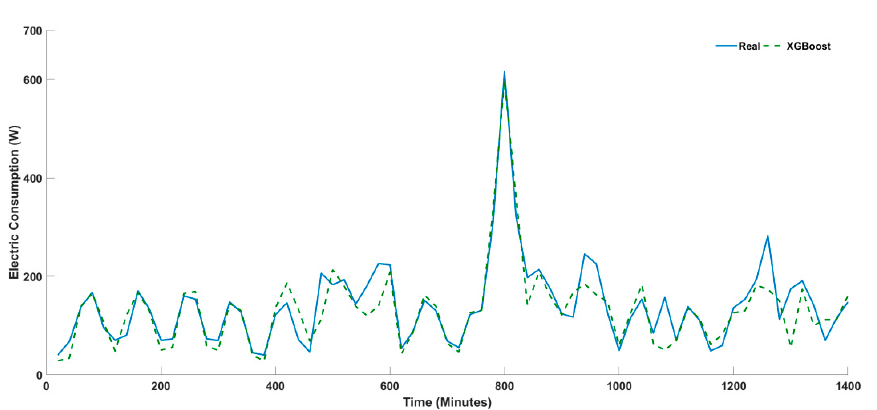
Figure 8. SARIMAX for multivariate time series.